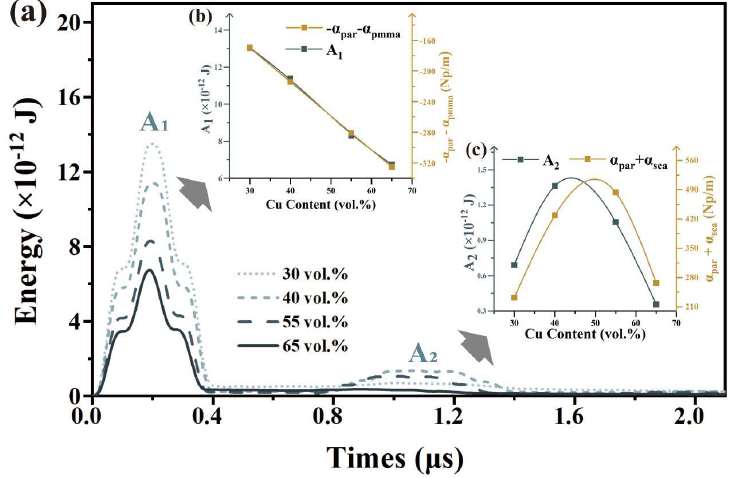
Figure 9. Analysis of mechanical energy after wave of 10 µm Cu/PMMA: ( a ) Mechanical energy intensity; ( b ) Height of the first peak(A 1 ) and (−𝛼 (cid:3040)(cid:3028)(cid:3047) − 𝛼 (cid:3043)(cid:3028)(cid:3045) ) ; and ( c ) Height of the second peak(A 2 ) and ( α par + α sca ).